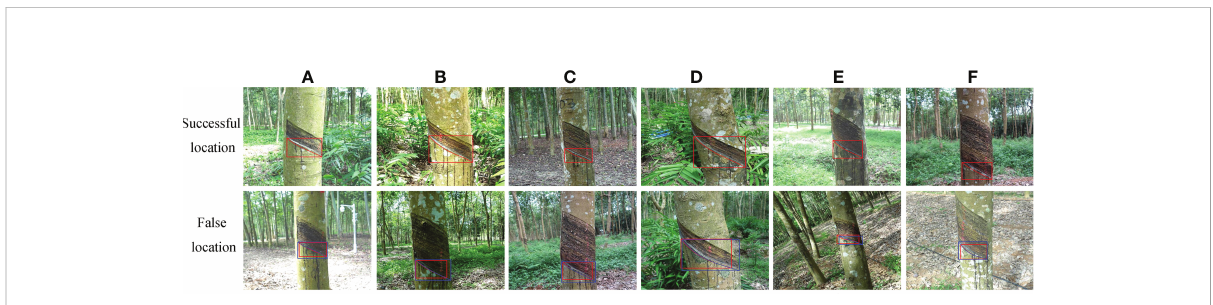
FIGURE 10 Location effects of new tapping line under different shooting conditions. (A) Sunny and sunlight. (B) Sunny and backlight. (C) Cloudy. (D) One year. (E) Two years. (F) Three years.